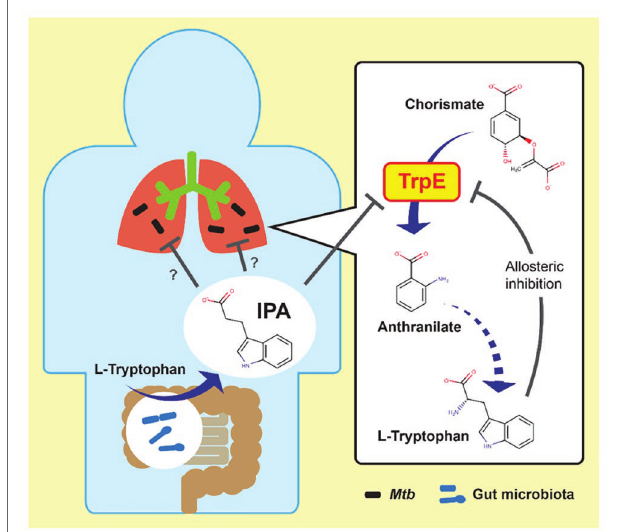
FIGURE 1 | Possible link between gut microbiota and mycobacterial lung disease. Left: indole propionic acid (IPA) is produced by gut bacteria from tryptophan and enters the blood stream. Right: IPA inhibits mycobacterial tryptophan biosynthesis by targeting anthranilate synthase TrpE, mimicking tryptophan as allosteric inhibitor. Mtb, Mycobacterium tuberculosis